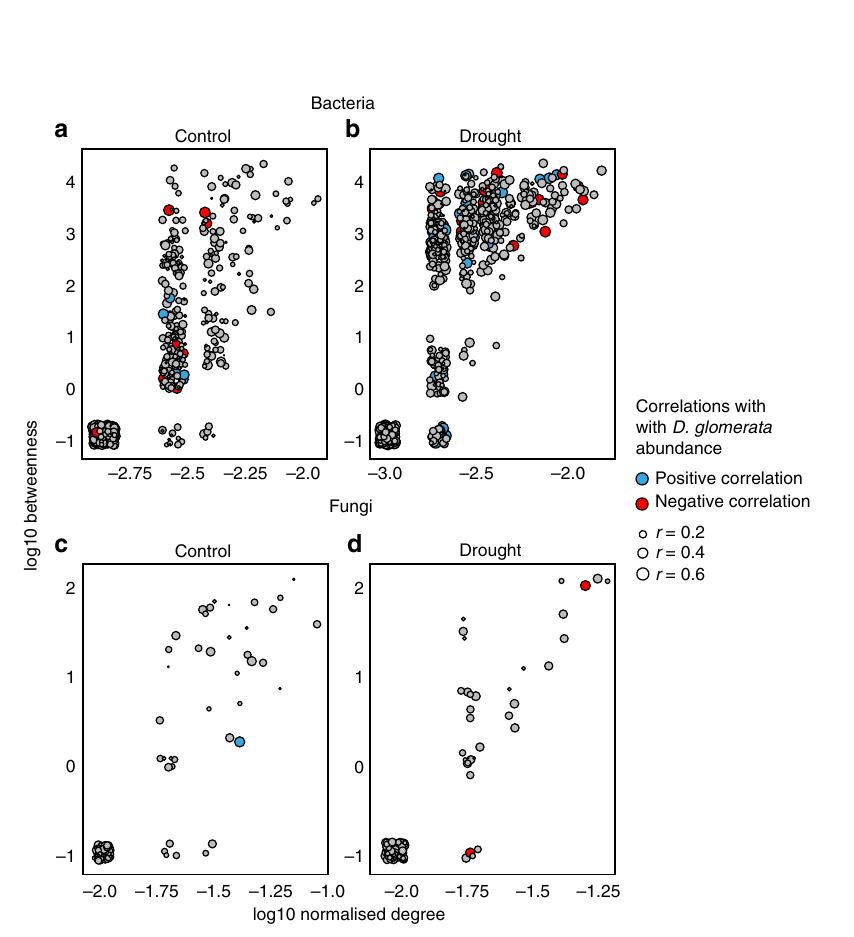
Fig. 7 Relationship between network properties and correlation with D. glomerata biomass at the late recovery sampling time point. Symbol size indicates the strength of the correlation of that node with D. glomerata abundance; blue and red symbols indicate signi fi cant positive and negative correlations with D. glomerata , respectively, while grey symbols represent non-signi fi cant correlations. All networks had a positive correlation between node-normalised degree and betweenness ( a – d ), but only in bacterial drought networks, there was a strong positive relationship between both normalised degree and betweenness and the strength of node correlation with D. glomerata abundance (ANCOVA normalised degree × Drought interaction F 1,1676 = 25.9, P < 0.001 and Betweenness × Drought interaction F 1,1676 = 14.5, P < 0.001 for bacteria ( b ); and Normalised degree F 1,225 = 1.1, P = 0.742, Normalised degree × Drought F 1,225 = 1.2, P = 0.275, Betweenness F 1,225 = 0.08, P = 0.772, Betweenness × Drought F 1,225 = 0.678, P = 0.411 for fungi ( d